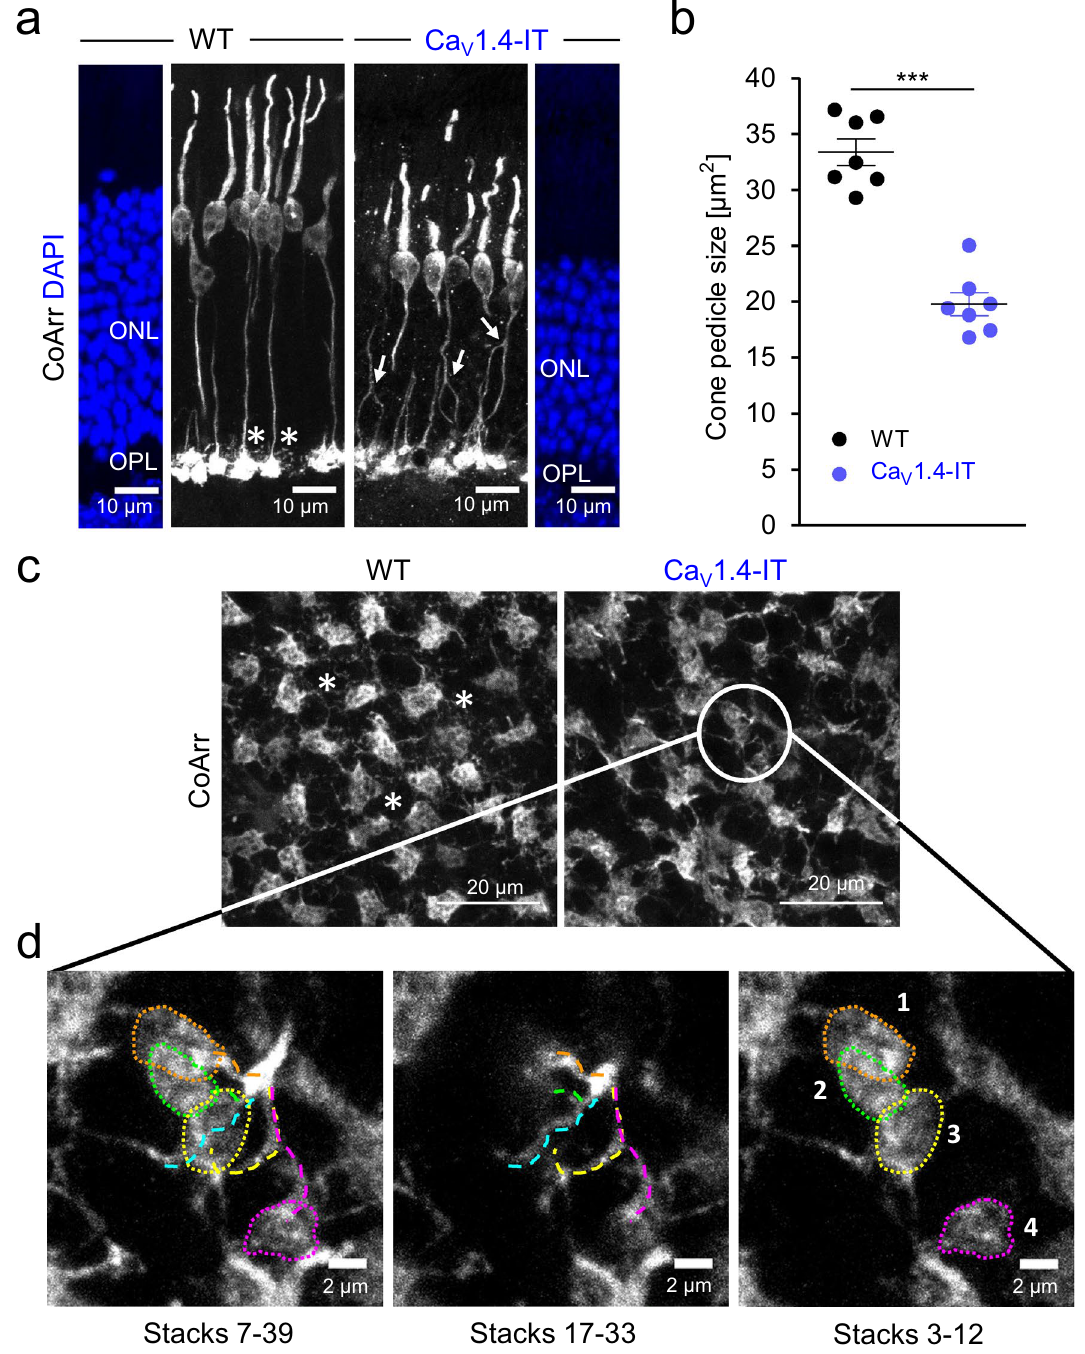
Figure 2. Cone photoreceptor terminals in Ca V 1.4 mutant retinas. ( a ) Cone photoreceptors were positive for cone arrestin (CoArr). Their terminals are located in the outer plexiform layer (OPL) as can be derived from the DAPI counterstainings (blue) of the vertical sections. Asterisks indicate telodendrial processes. Arrows point to axonal branches in the ONL. ( b ) The size of the cone pedicles was measured in whole mount stainings of WT (black) and Ca V 1.4-IT (blue) retinas: [µm 2 ]: WT: 33.5 ± 1.2; Ca V 1.4-IT: 19.9 ± 1.3. WT: N = 7, n = 74;